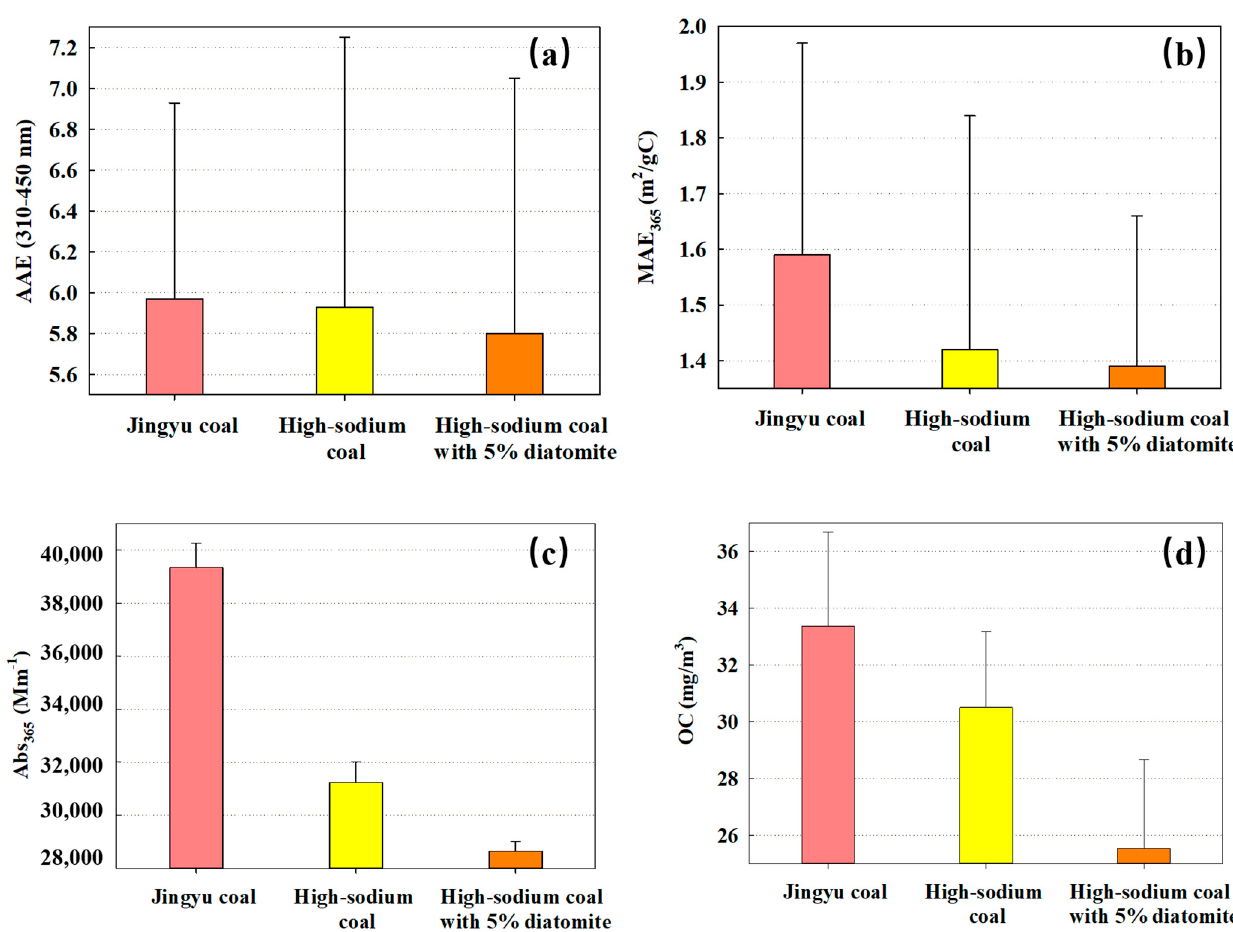
Figure 3. ( a ) AAE, ( b ) MAE 365 and ( c ) Abs 365 for methanol soluble organic in PM 2.5 and ( d ) OC concentration of PM 2.5 .